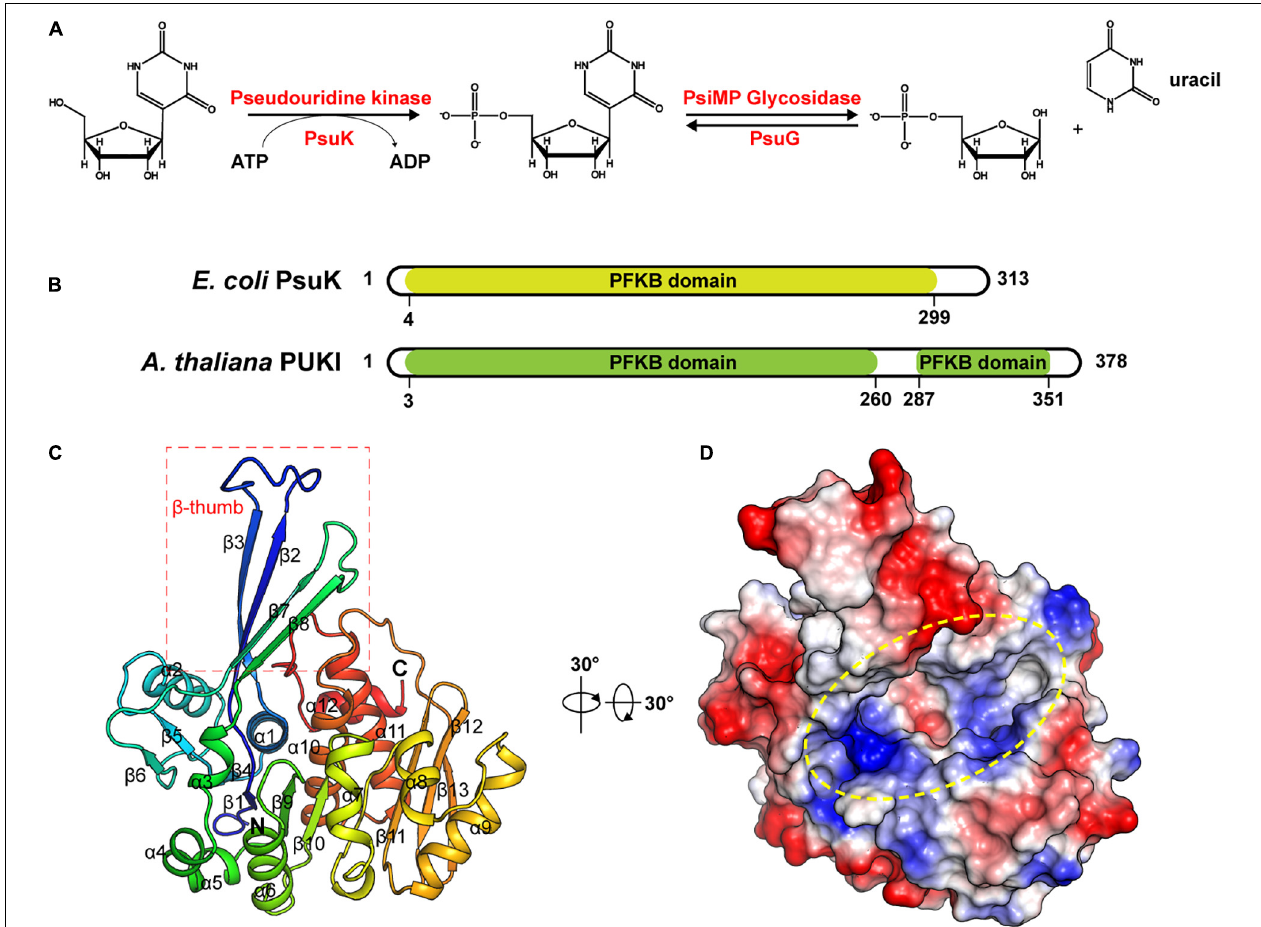
FIGURE 1 | Structure of apo- Ec PsuK. (A) Reaction scheme of pseudouridine metabolism. (B) Domain organization of Arabidopsis PUKI and E. coli PsuK. (C) Overall structure of Ec PsuK is colored in the rainbow. β -Thumb region is indicated by a red box. (D) Surface representation of apo- Ec PsuK, and the potential substrate-binding pocket is indicated by a yellow